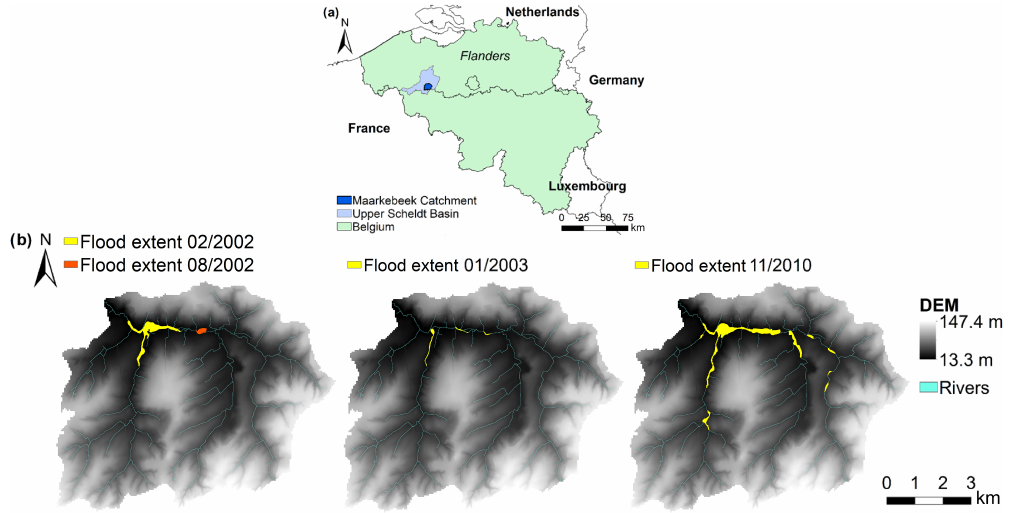
Figure 4. Extents of flooded areas in the Maarkebeek basin as recorded in the geospatial flood archive for the 2000–2016 period (AGIV et al., 2006; AGIV and VMM, 2017). One flood extent was recorded in February and August 2002, respectively; these extents do not overlap and are depicted in the same figure. Three and eight flood extents were recorded in the flood events in 2003 and 2010, respectively. Please note that the date format used in this figure is